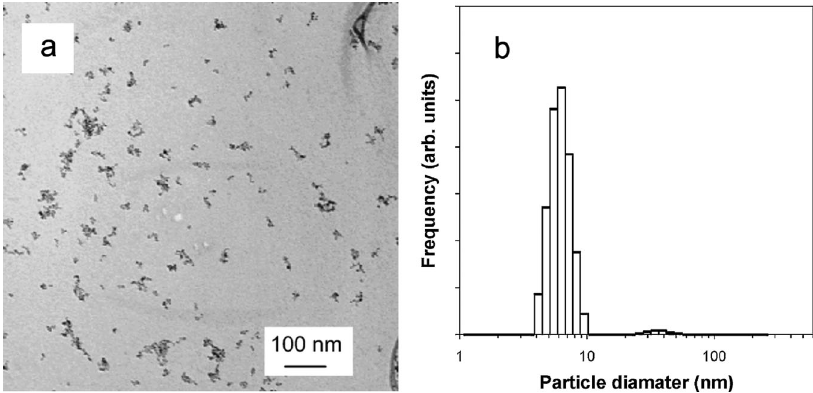
Fig. 2 Mechanochemically synthesised γ -Fe 2 O 3 single-crystalline nanoparticles 93 . a Transmission electron micrograph. b Particle-size distribution obtained from electron micrographs. Reproduced with permission from